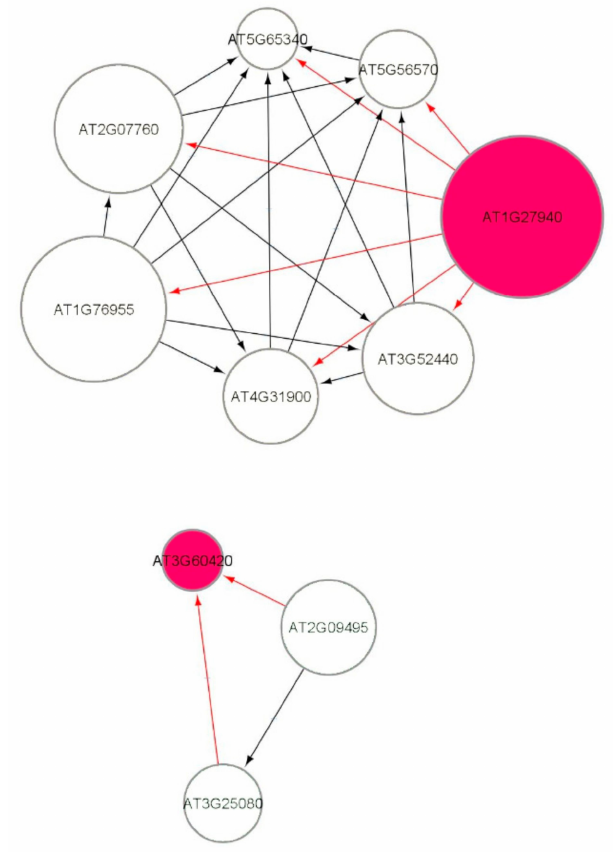
Figure 7. Markov blanket subnetworks for low radiation dose dataset (LRD1).